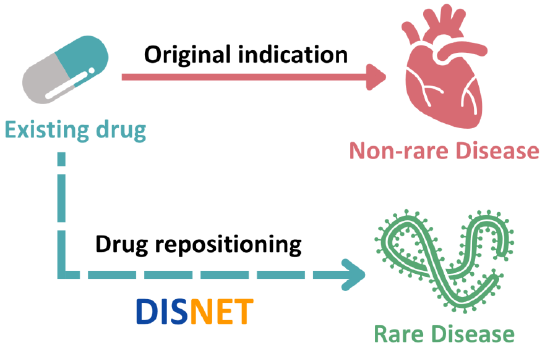
Figure 3. Description of the methodological background of the main objective of the study.